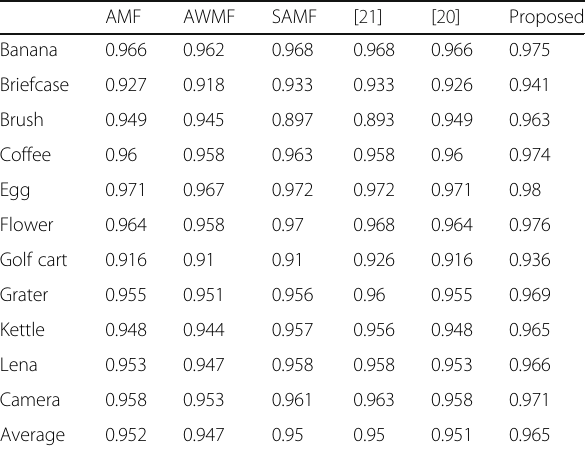
Table 5 PSNR comparison for 50% noise (dB) AMF AWMF SAMF [21] [20]